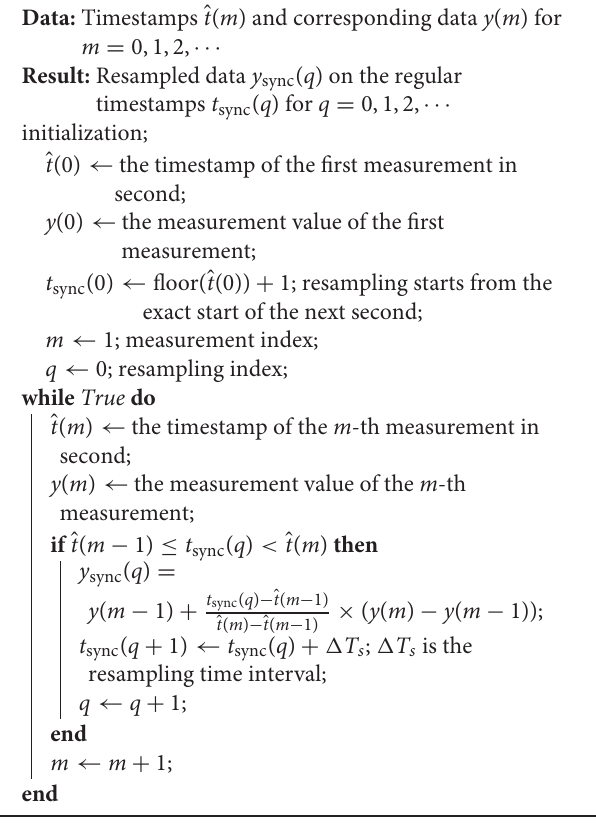
Algorithm 1: Pseudo code of the implemented resampling. Data: Timestamps t ( m ) and corresponding data y ( m ) for ˆ